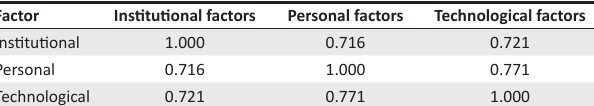
TABLE 4: Factor correlation matrix.